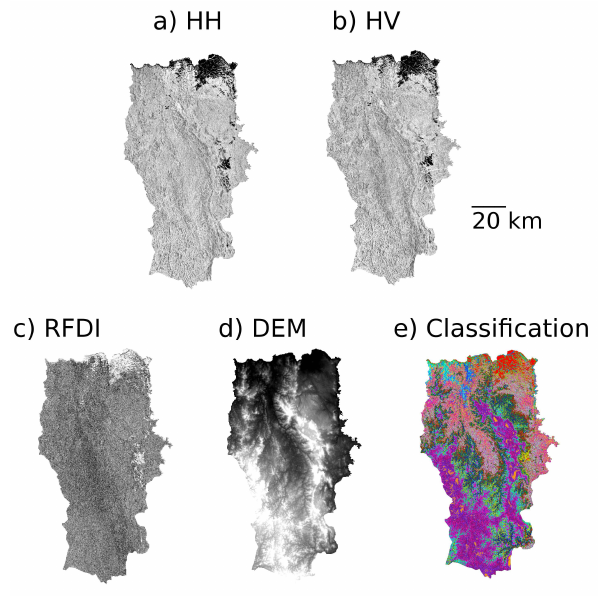
Fig. 3. Images of Lop´e National Park using (a) PALSAR HH, (b) PALSAR HV, (c) Radar Forest Degradation Index (RFDI), (a) Digital Elevation Model (DEM), (e) Classified map, showing 40 classes with arbitrary colours.